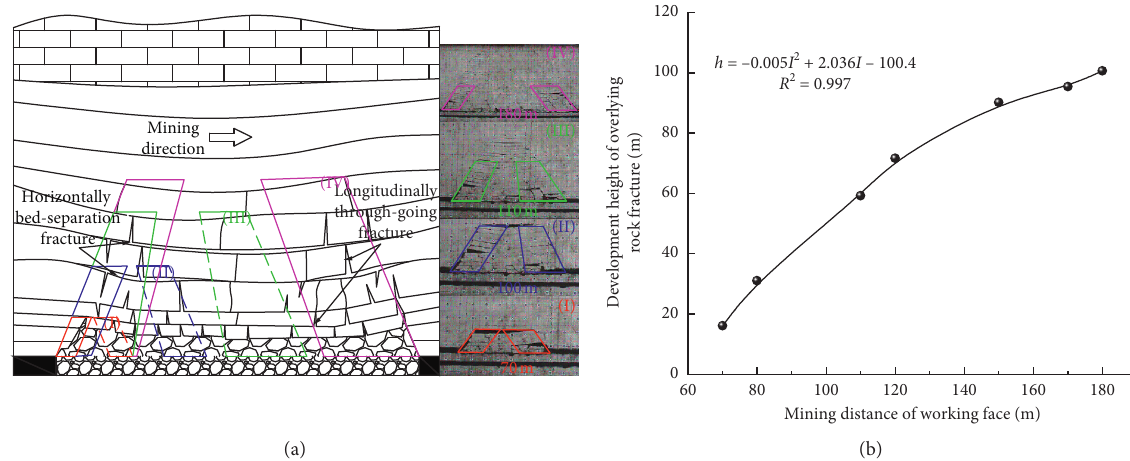
Figure 6: The relationship between mining distance of the working face and caving height of caving zone.